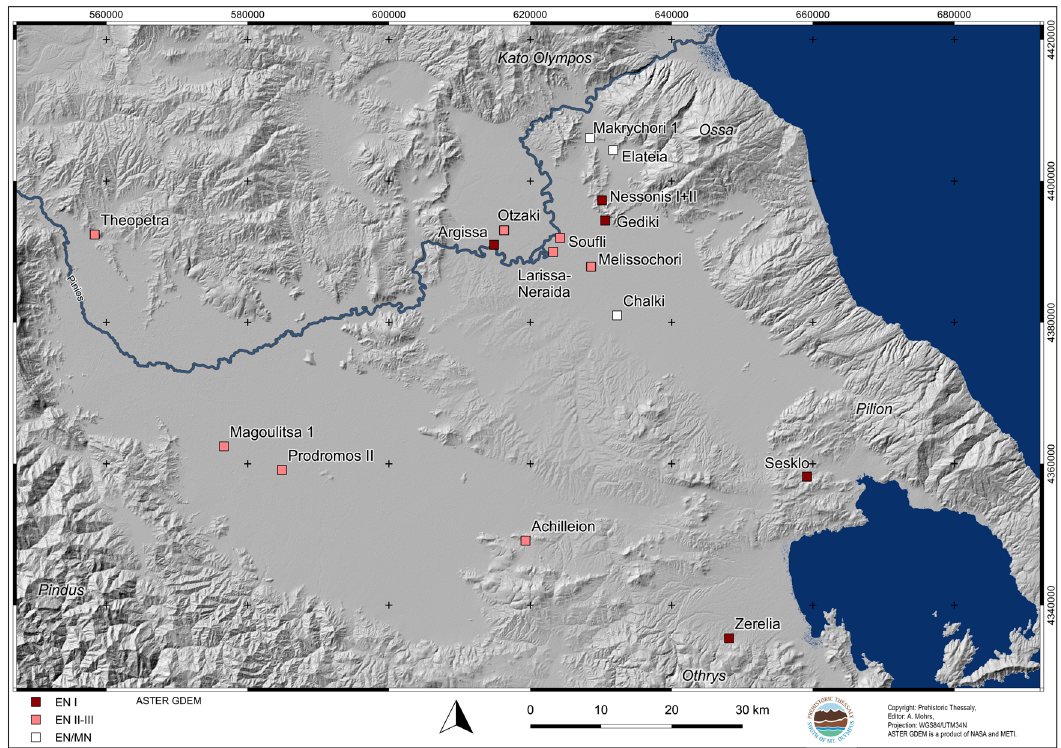
Figure 1: Map of Thessaly with the securely dated Early Neolithic sites mentioned in the text ( Agathe Reingruber and Amelie Mohrs )